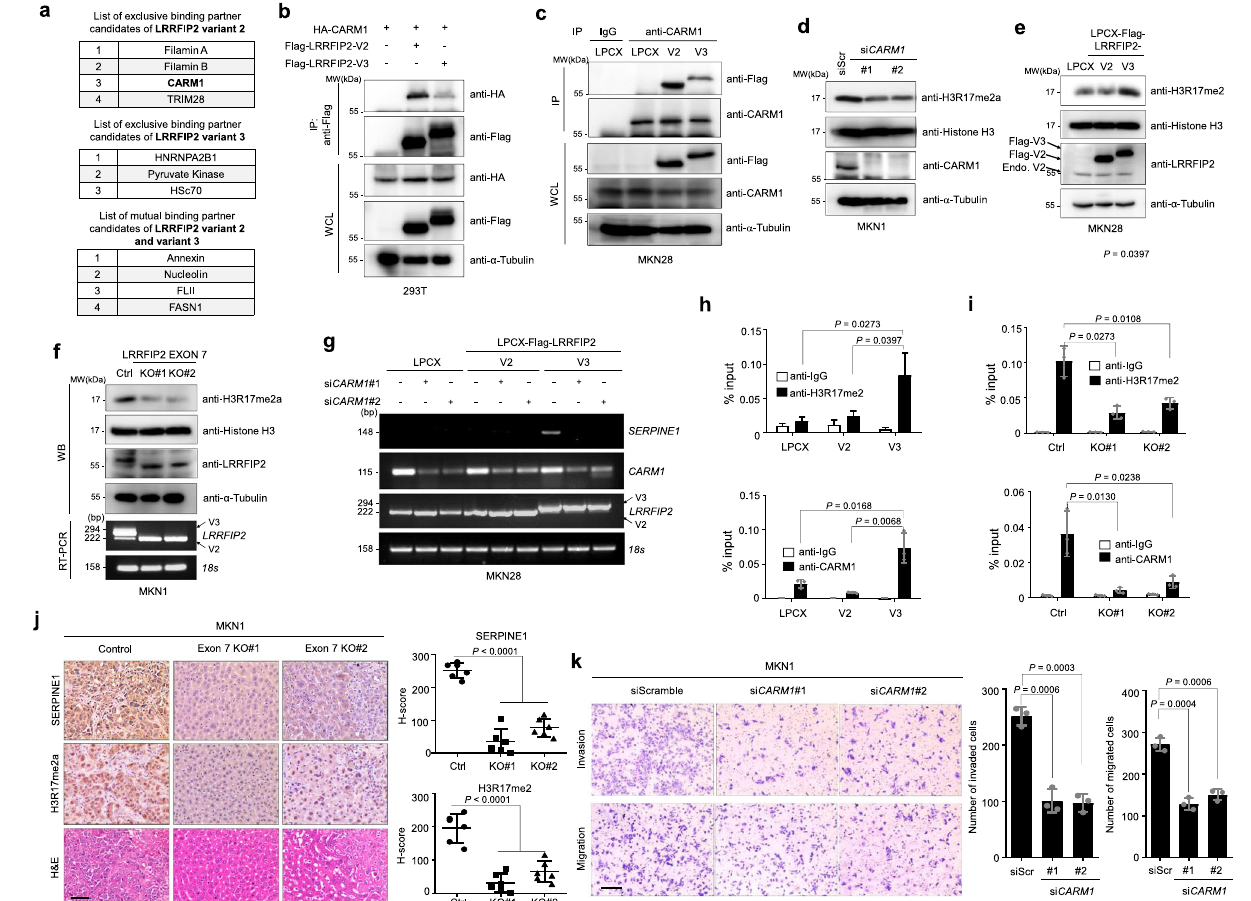
Fig. 4 | Alternative splicing of LRRFIP2 regulates histone methyltransferase activityofCARM1throughspeci fi cinteraction.a ListofLRRFIP2bindingpartner candidates analyzed from the mass spectrometry-base crosslinking assay. b Immunoprecipitation assay showing the interaction between HA-CARM1 and Flag-LRRFIP2variant2or3in293Tcells. c Immunoprecipitationassayshowingthe interactionbetweenLRRFIP2variant2or3andendogenousCARM1. d Immunoblot analysisshowingH3R17me2a,histoneH3,andCARM1incontrolandCARM1siRNA- treated cells. e Immunoblot analysis showing H3R17me2a, histone H3 and Flag in LRRFIP2 variant 2 and 3-overexpressing MKN28 cells. f Immunoblot and RT-PCR analysisshowingH3R17me2a,histoneH3and LRRFIP2 incontrolandexon7-deleted cell lines. g RT-PCR analysis showing expression of SERPINE1, CARM1, LRRFIP2 in LRRFIP2 variant 2 or 3-overexpressing MKN28 cells, with CARM1 knockdown by siRNA transfection. h , i qChIP analysis of the human SERPINE1 promoter with antibodies to CARM1, H3R17me2a in h LRRFIP2 variant 2 and